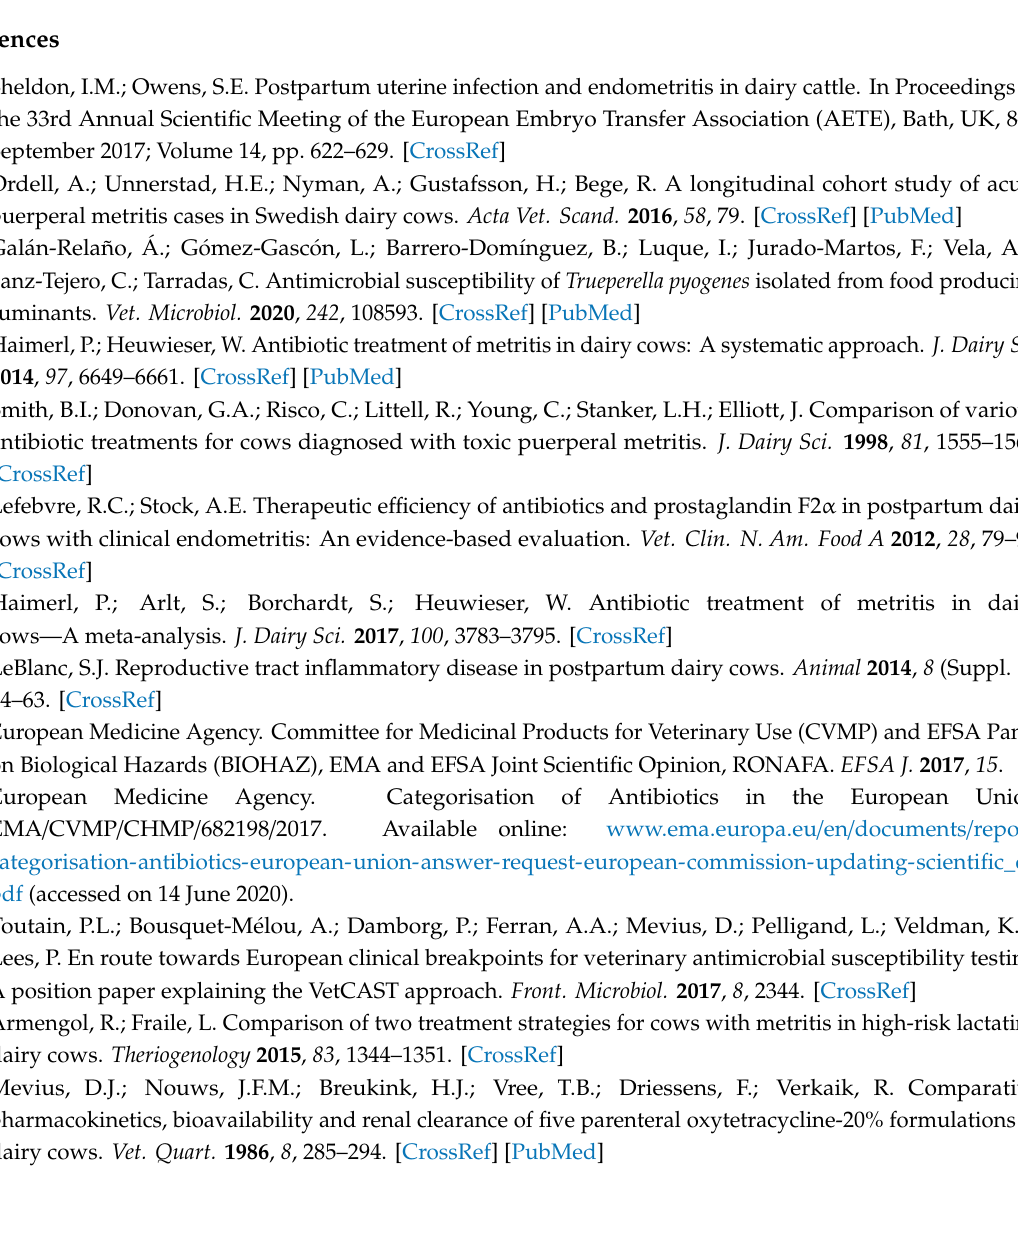
Table S1: Information about cows included in the investigation; Table S2: Measured concentrations of oxytetracyclineinplasmaofeachcow( n = 6)aftersingleintramuscularadministrationof20mgkg − 1 oxytetracycline hydrochloride as a long-acting drug formulation; Table S3: Measured concentrations of oxytetracycline in milk of each cow ( n = 6) after single intramuscular administration of 20 mg kg − 1 oxytetracycline hydrochloride as a long-acting drug